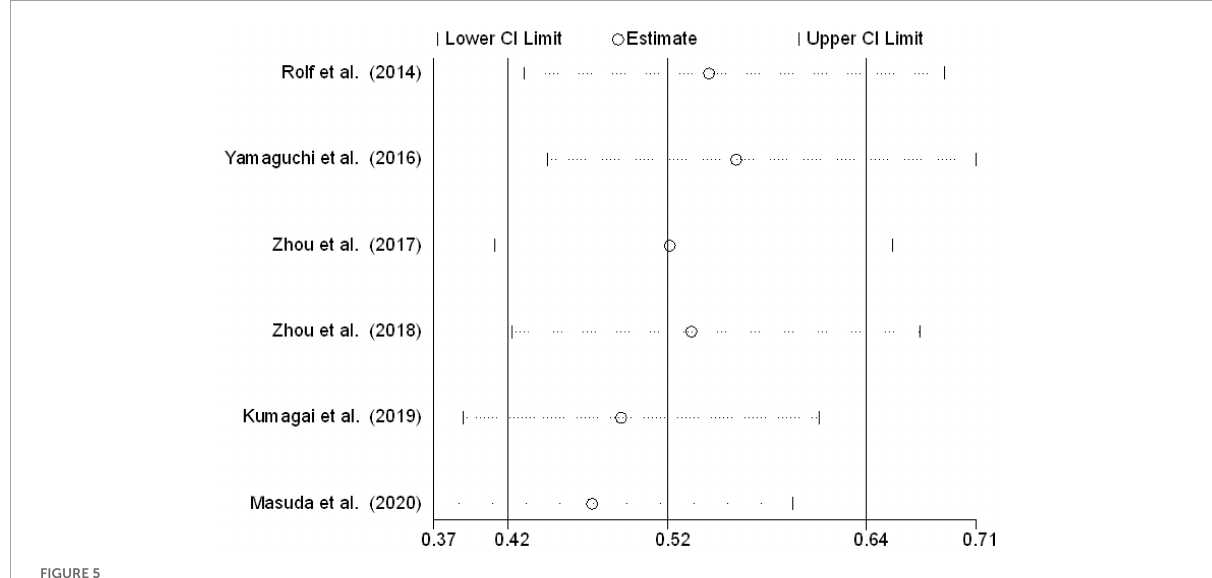
FIGURE5 Sensitivity analysis of LVAs ablation in AF patients with